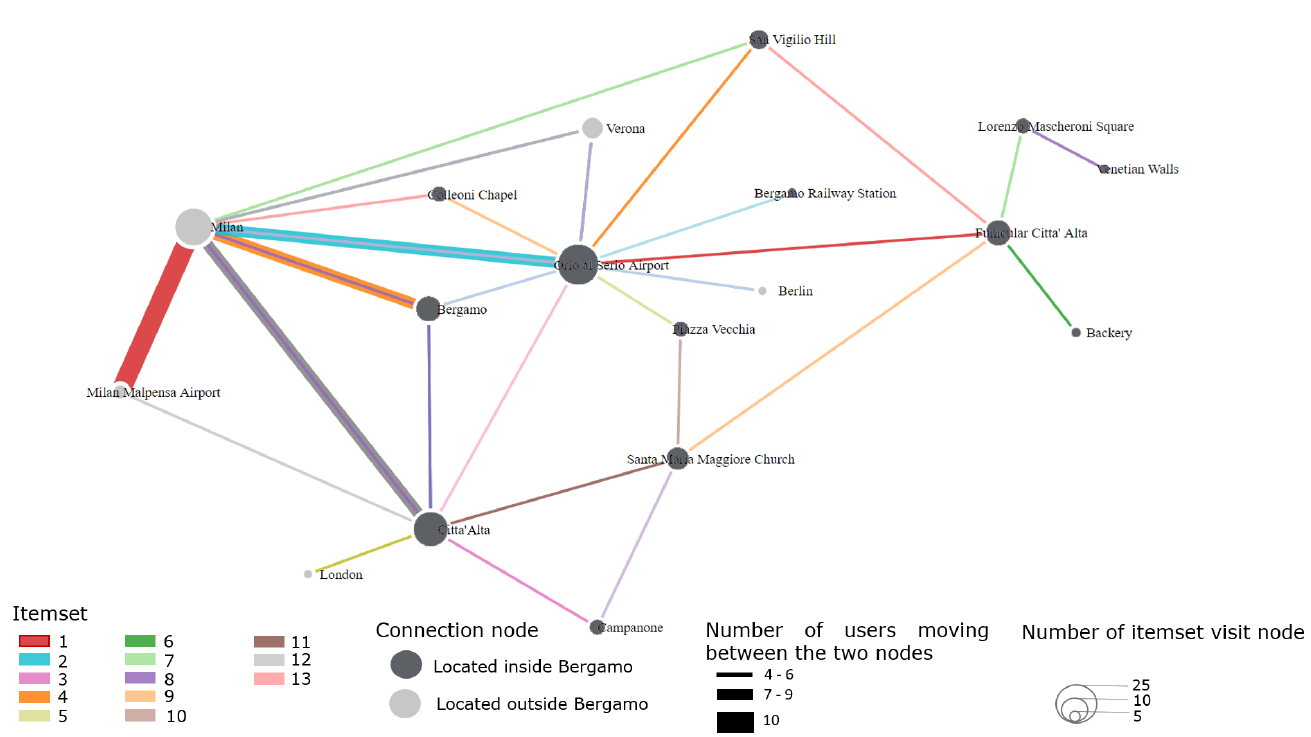
Figure 4. Topological representation depicting the itemsets obtained by running the itemset-mining algorithm on the case-study data set with Interpretation